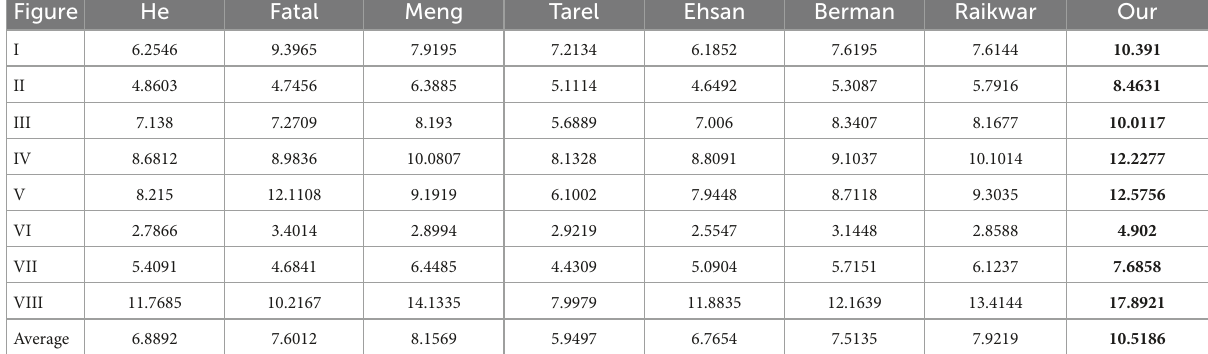
TABLE 6 Comparison of average gradient (AG) of the defogging images. Figure He Fatal Meng Tarel Ehsan Berman Raikwar